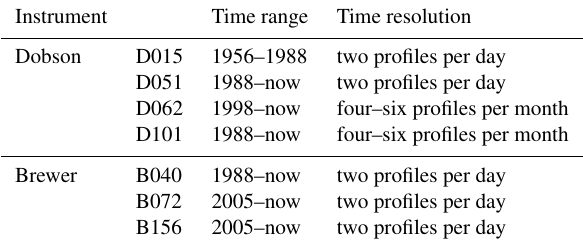
Table 1. Time ranges and time resolutions of the Dobson and Brewer Umkehr measurements at the Arosa/Davos